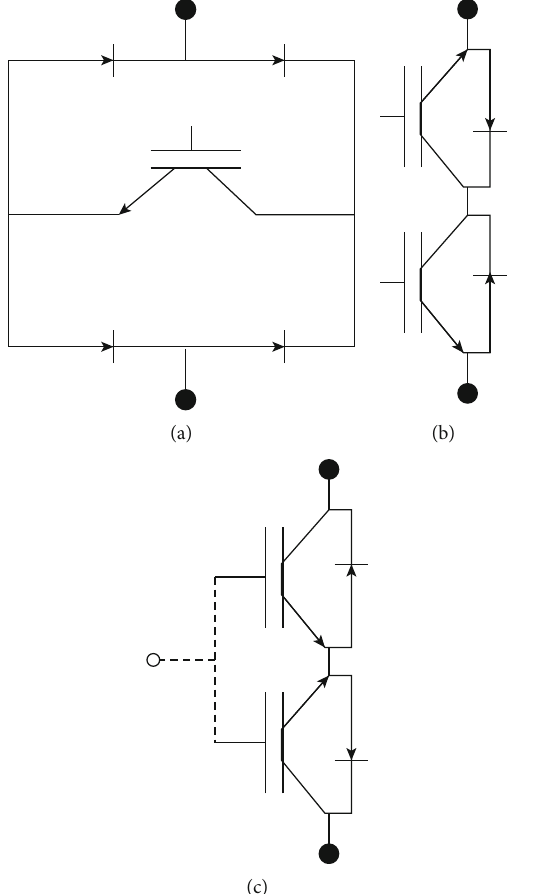
Table 5: Comparison between